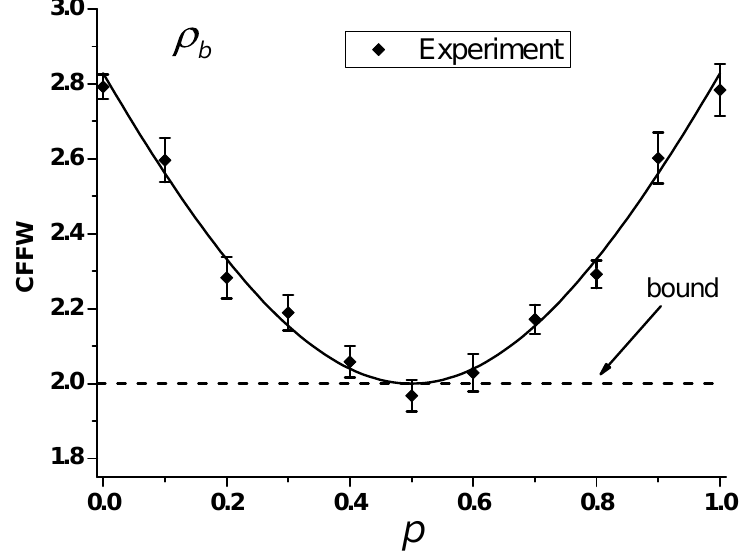
Figure 6. Experimental violations of the CFFW inequality as a function of the state parameter p for different Bell diagonal states ρ b . The diamond symbols represent the experimental data. The solid line represents the theoretical prediction. The dashed line represents the bounds of violation of the CFFW inequality. Error bars are due to the statistical uncertainty. The experimental results match well with theoretical